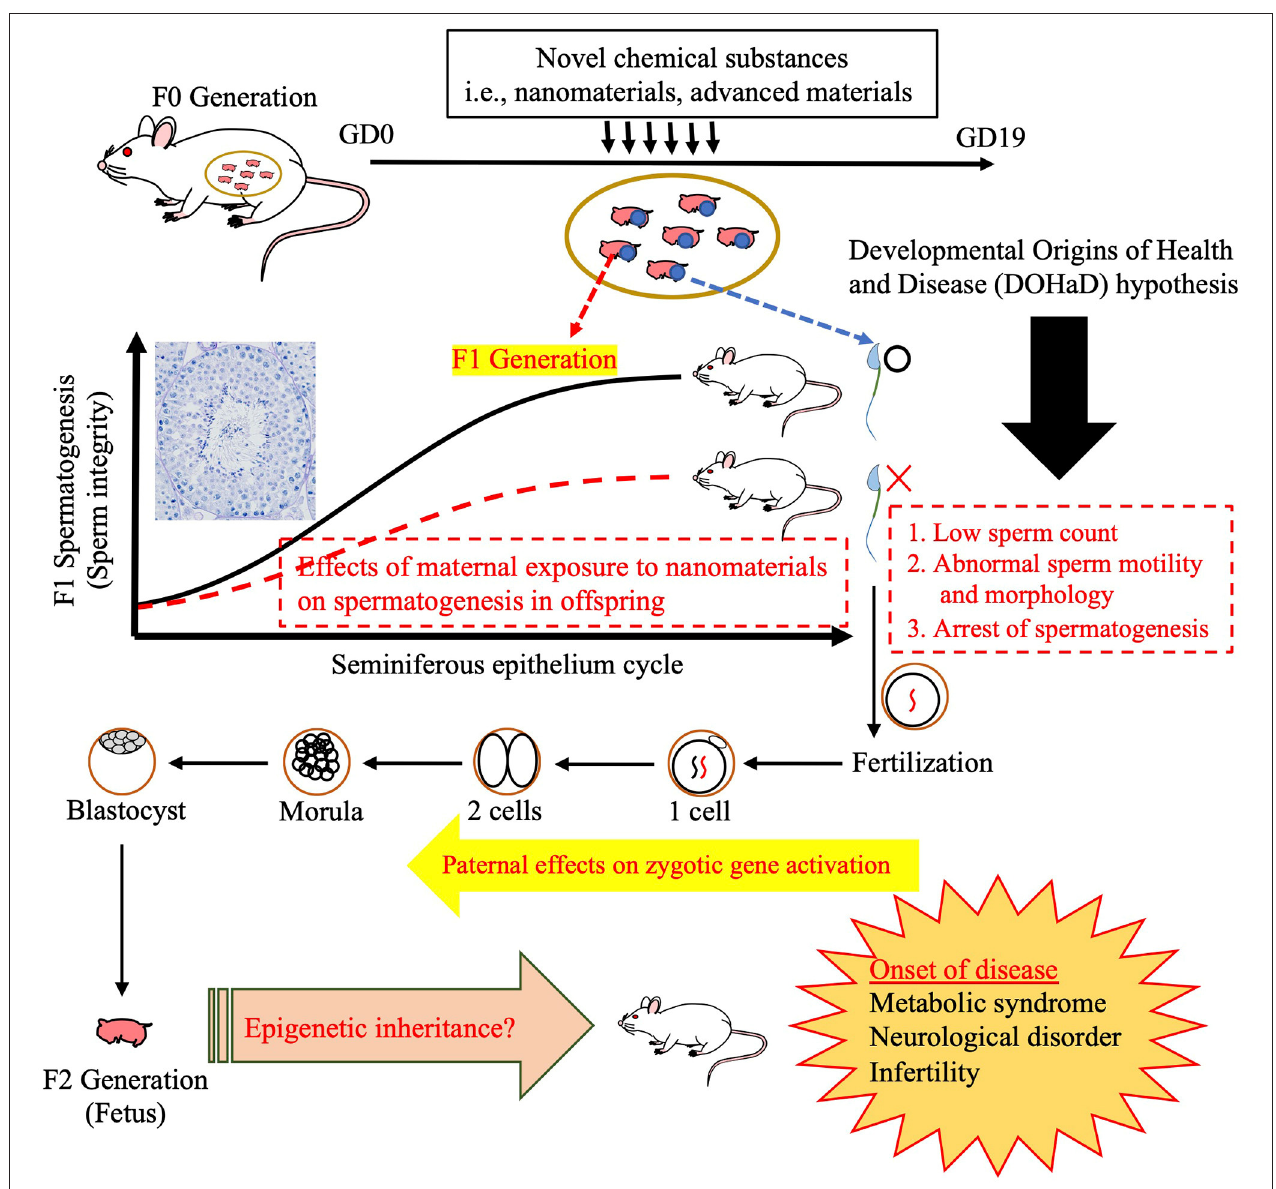
FIGURE 3 | Illustration of intergenerational (F1) and transgenerational (F2) effects. The testis morphology shown demonstrates the cooperation of somatic cells and spermatogenic cells during spermatogenesis. Schematic of susceptibility windows for testicular toxicity in the F1 generation caused by prenatal exposure to nanomaterials (NMs), followed by the induction of potential toxicity mechanisms via the F1 germline to trigger transgenerational inheritance to the F2 generation, which is not subject to direct NM exposure. After mating with control females, phenotypic alterations are often observed in offspring in these paradigms. Illustrated here are a number of probable disease onset mechanisms underlying such paternal effects, including alterations in the sperm